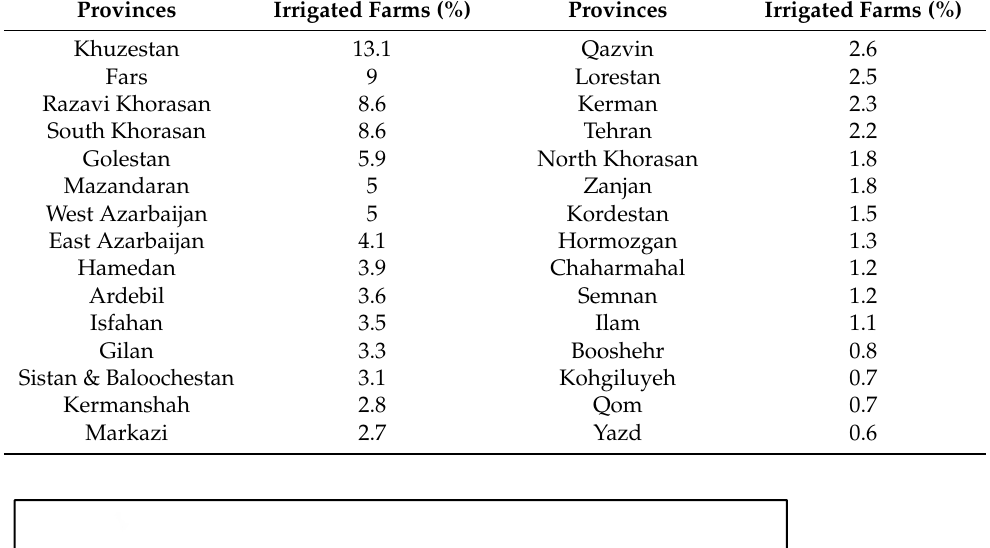
The final exposure map was produced by overlaying the irrigated percentage and the population density layers (Figure 12). The lightest (0) and darkest (1) colors indicate the least and most exposure to drought, respectively.